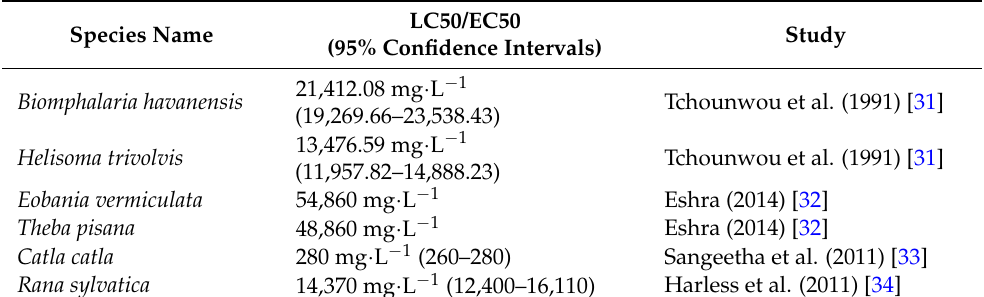
Table 8. Lethal or effective concentration and their confidence intervals (when present, shown in parentheses) for urea in studies with aquatic